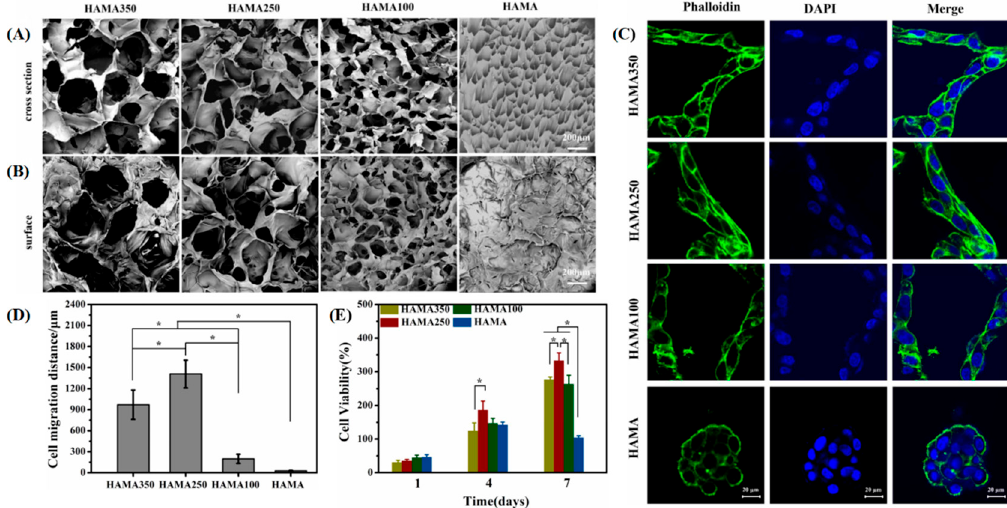
Figure 5. Cell behavior of vascular endothelial cells in hydrogels with different pore sizes. SEM images of cross-section ( A ) and surface ( B ) of HAMA350, HAMA250, HAMA100, and HAMA hydrogels. Scales = 200 µ m. ( C ) Representative confocal images of HUVECs on hydrogels after 7 d. The cytoskeleton was stained with iFluorTM 488 Phalloidin (green) and the nucleus was stained with DAPI (blue). Scales = 20 μ m. ( D ) Cell 3D migration distances into HAMA350, HAMA250, HAMA100, and HAMA hydrogels after 7 d culture in vitro (* p < 0.05). ( E ) Cell proliferation of HUVECs seeded on HAMA350, HAMA250, HAMA100, and HAMA hydrogels after 1, 4, and 7 d by CCK-8 assay (* p < 0.05). Reprinted with permission from [194], Copyright 2022, IOP